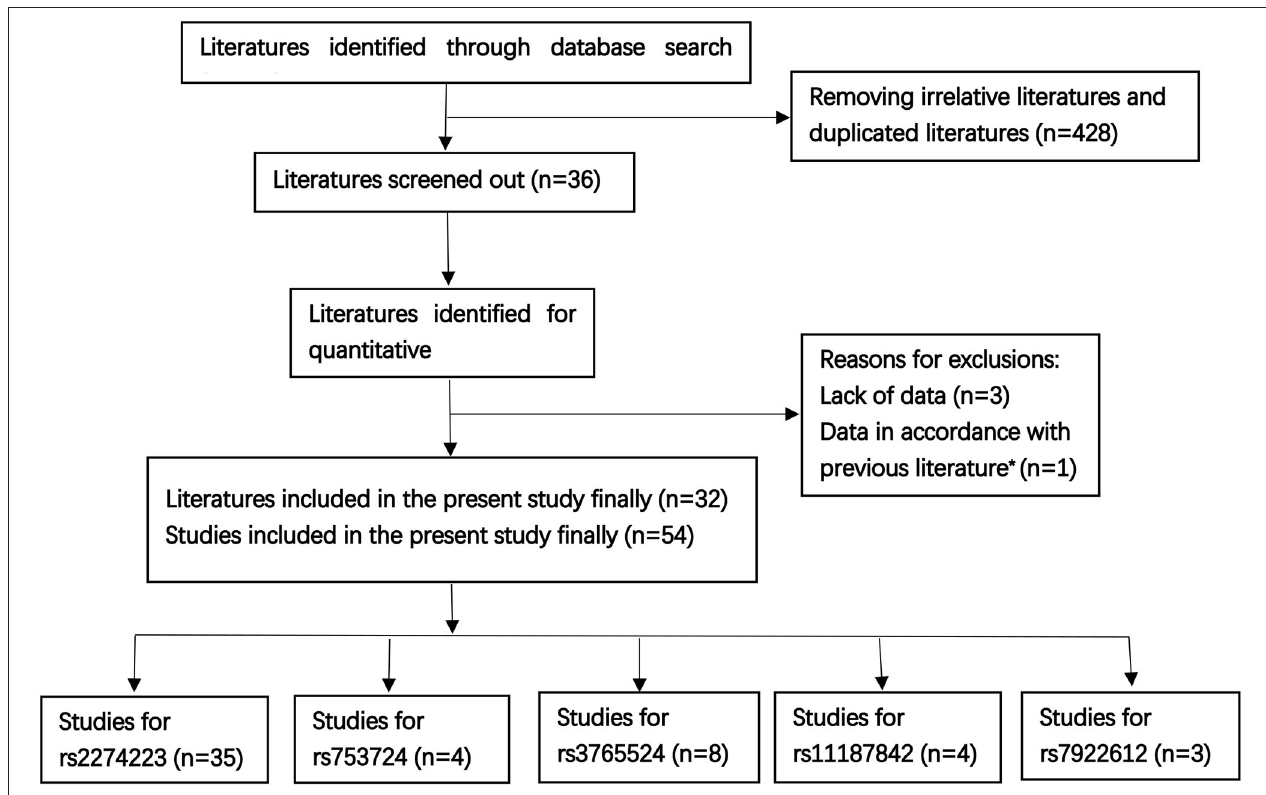
FIGURE 1 | The workflow of the enrollment [Literatures sources: PubMed n = 112, Web of Science n = 201, other literatures were supplemented by Medline, EMbase, and Scopus, as well as the references of qualified literatures or other reviews; previous literature * (13)].